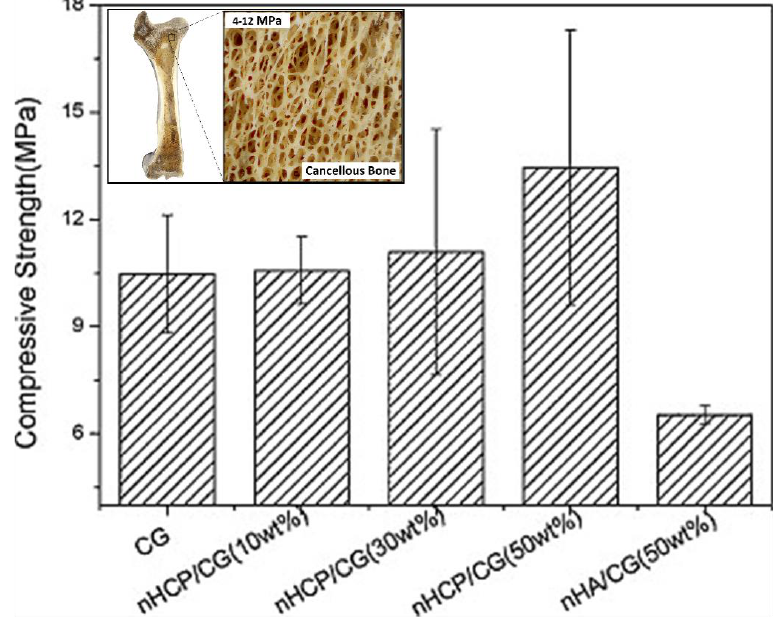
Figure 7. Compressive strength of the different protein – polysaccharide composites: Bulk composite of nHCP/CG (nHA/chitosan – pectin/chitosan – gelatin) is similar to that of cancellous bone (reproduced with permission from [123], copyright Elsevier, 2011).